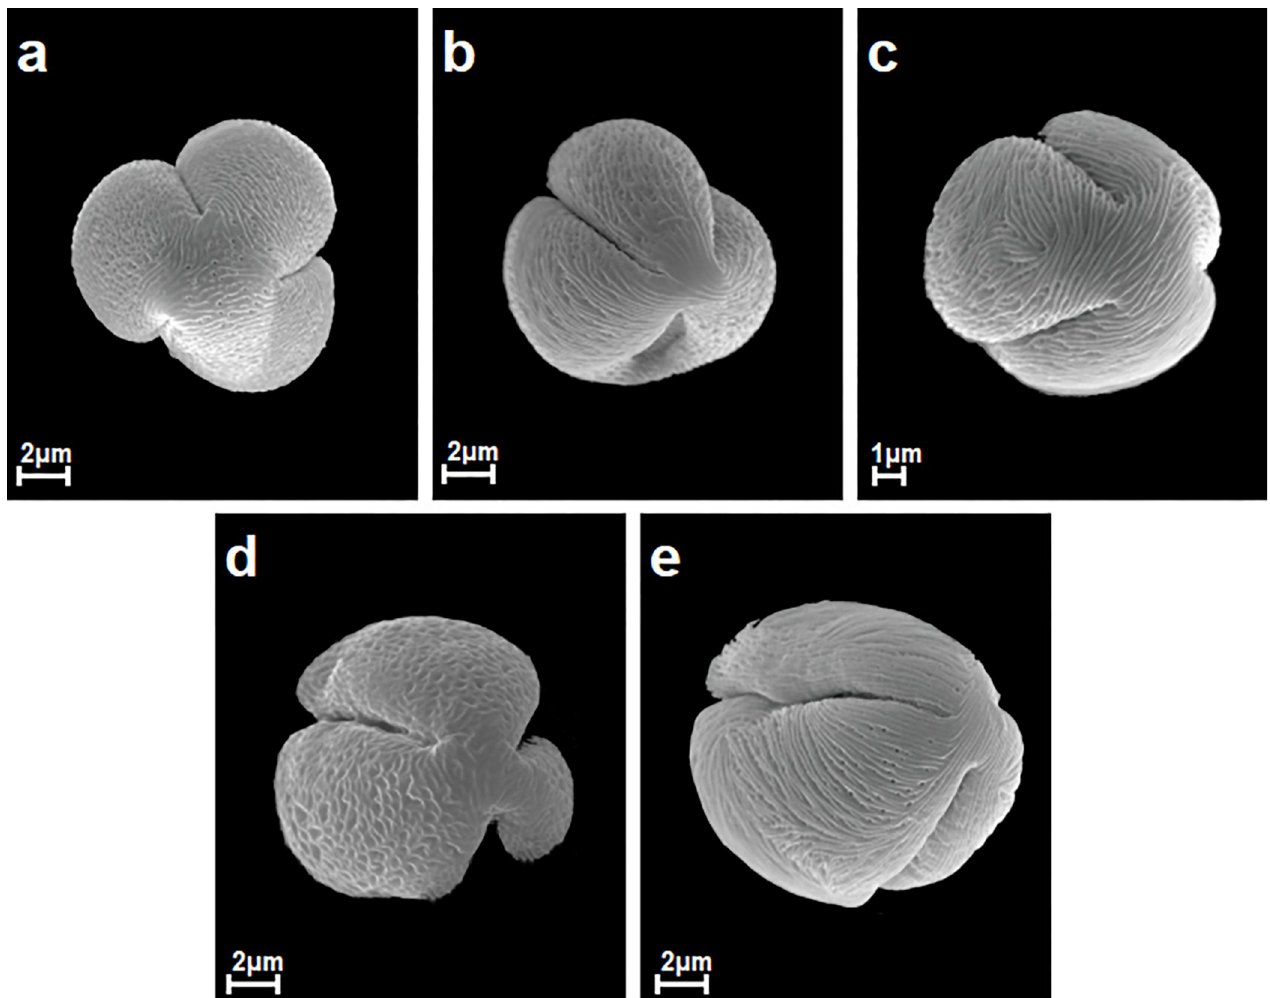
Fig 1. Pollen grains in polar view in S . douglasii , S . elegans , S . thunbergii , S . japonica , S . uratensis , A-E.